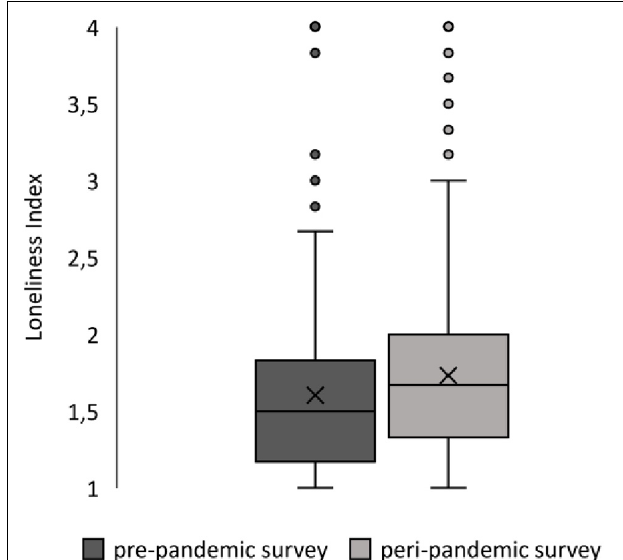
FIGURE 2 | Differences in reported loneliness between pre- and peri-pandemic surveys. Box plots show the distribution and mean value of reported loneliness on pre- and peri-pandemic survey time points. X=mean value, outliers show that lonelier participants were present, if atypical in both